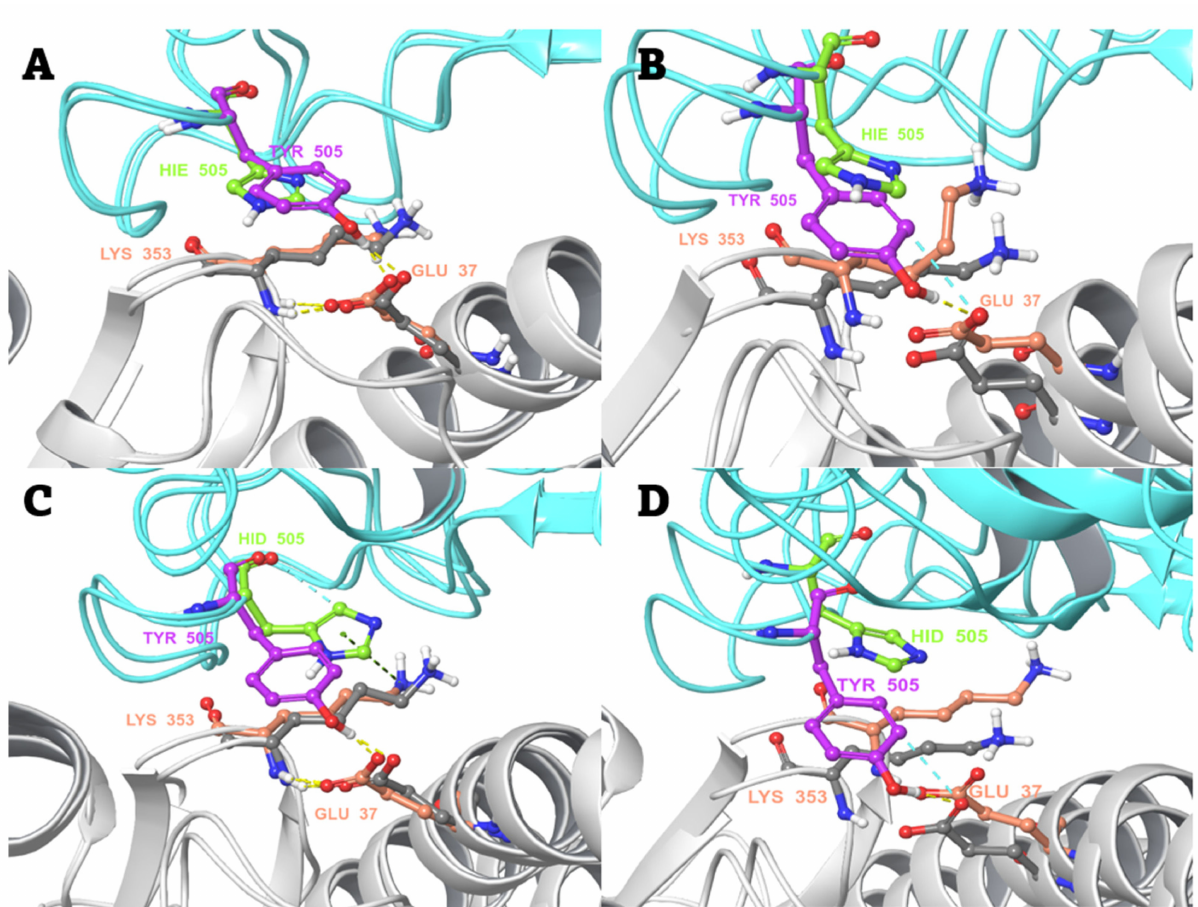
Figure 5. The change in local environment at the binding interface of SARS-CoV-2 spike RBD and hACE2 caused by Y505H mutation. The orientation and interactions of Tyr505 of WT spike RBD and HIE505 (protonated ε nitrogen) of the mutant, with respect to Glu37 of hACE2 ( A ) before the start of production MD simulation, and ( B ) after a 200-ns MD simulation. The orientation and interactions of Tyr505 of spike RBD WT and HID505 ( δ protonated nitrogen) of the mutant, with respect to Glu37 of hACE2 ( C ) before the start of production MD simulation, and ( D ) after a 200-ns MD simulation. Colour scheme: spike RBD and hACE2 in cyan and white colour cartoon, respectively. Spike RBD and hACE2 amino acid residues in pink/grey (WT complex) and green/salmon (mutant complex) elemental ball and sticks representation, respectively. Interactions are shown in dashed lines: yellow—H-bonds; light cyan—aromatic H-bonds; green—pi–cation